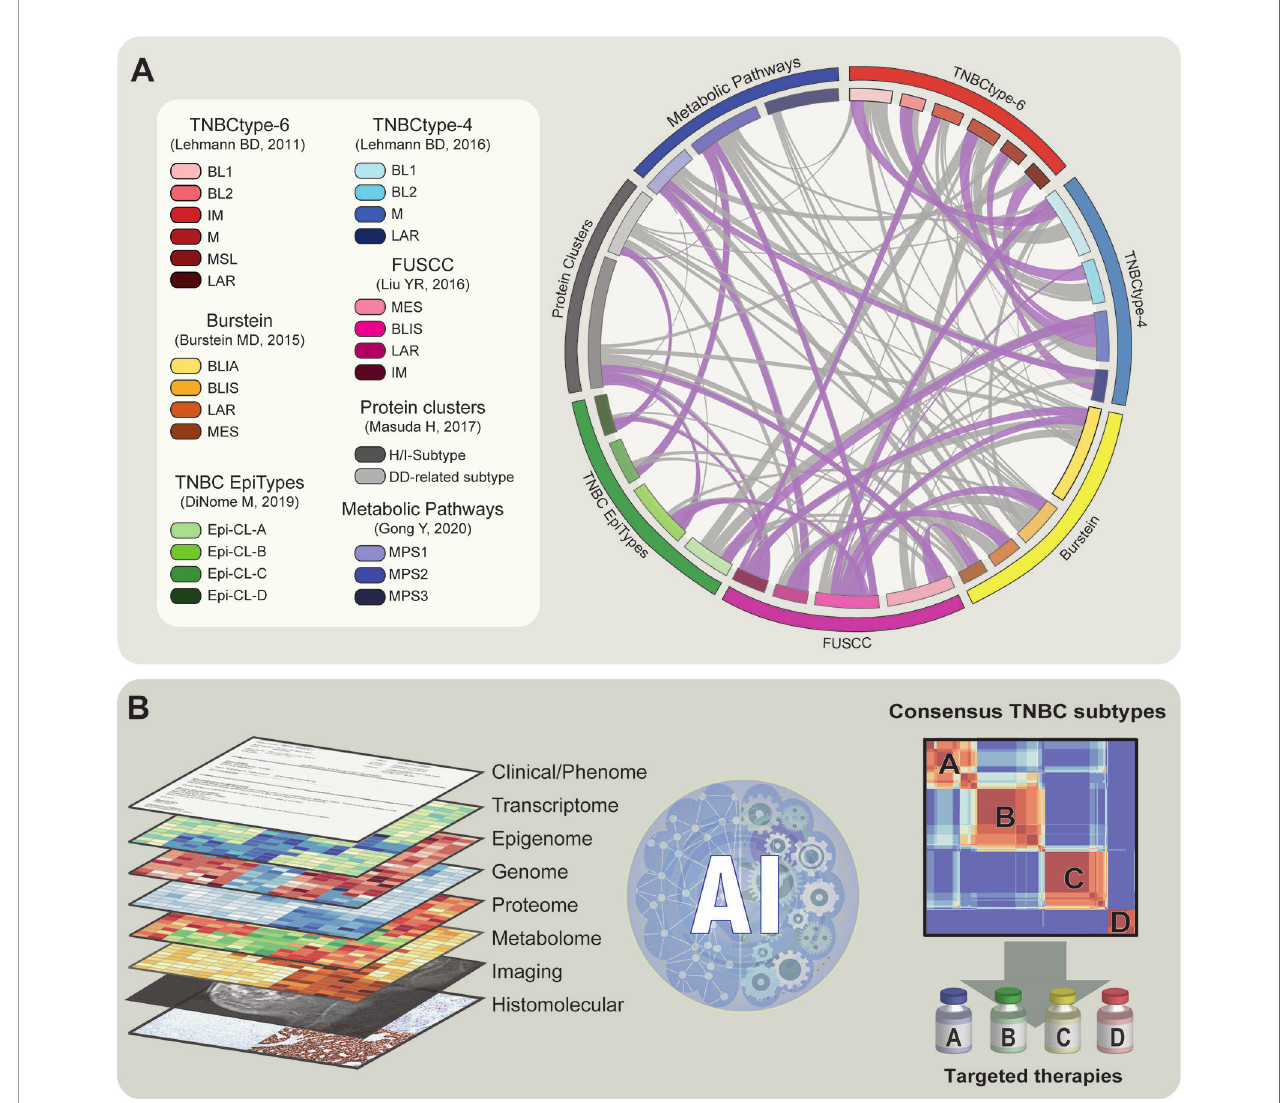
FIGURE 1 | Illustrative representation of current subtypes and the future of subsetting in TNBC. (A) Left panel: Summary of TNBC classi fi cation methods described and their subtypes. Right panel: Representation of the similitude between the different classi fi cation systems that reported comparisons with existing methods. Ribbons represent the partial overlap between different subtypes. Ribbons referring to strong overlaps are shown in purple. (B) Left panel: Schematic representation of the different layers of information to construct the de fi nitive TNBC subtypes. This includes clinical, molecular, and histological data. Middle plot: Representation of application of arti fi cial intelligence (AI) algorithm to integrate diverse datasets and construct TNBC subtypes. Right panel: Schematic correlation plot representing consensus integrative TNBC subtypes. TNBC strati fi cation can be applied to improve subtype-speci fi c